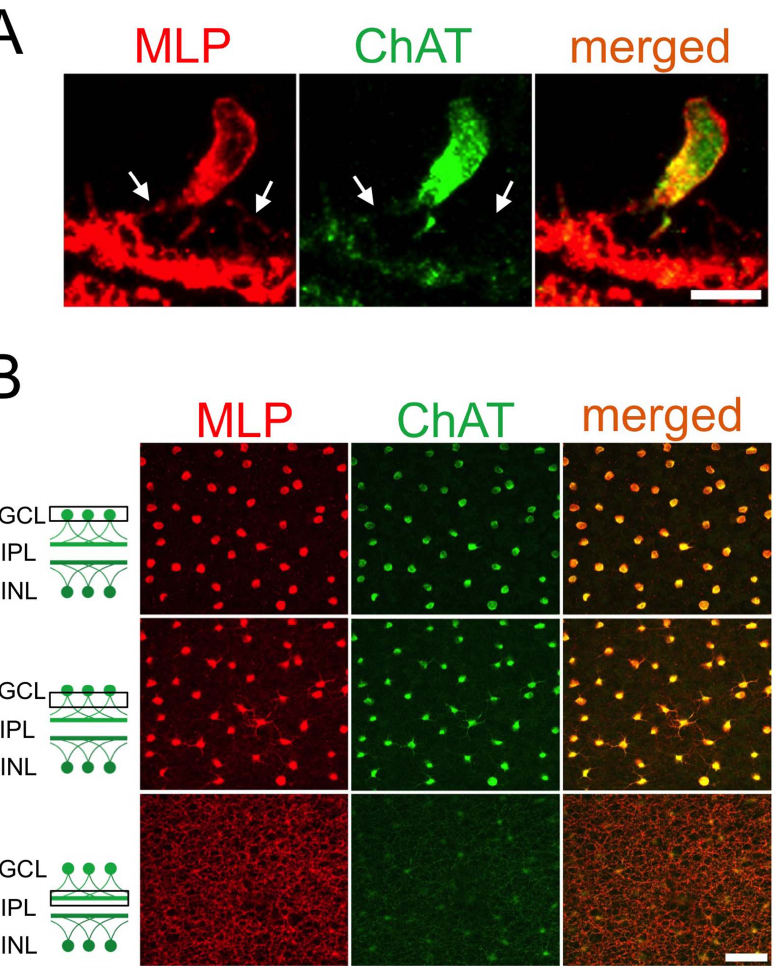
Figure 3. Subcellular localization of MLP in cholinergic AC. A : Confocal image of a MLP-positive cholinergic AC at P7, demonstrating MLP protein in the soma and the dendrites (arrows), but not in the nucleus. Scale bar: 10 m m. B : Confocal image of cholinergic AC in a retinal flatmount at P9, co-stained with antibodies against MLP and ChAT. The somas of all cholinergic amacrine cells as well as their proximal and distal dendrite segments are positive for MLP. Scale bar: 50 m m.